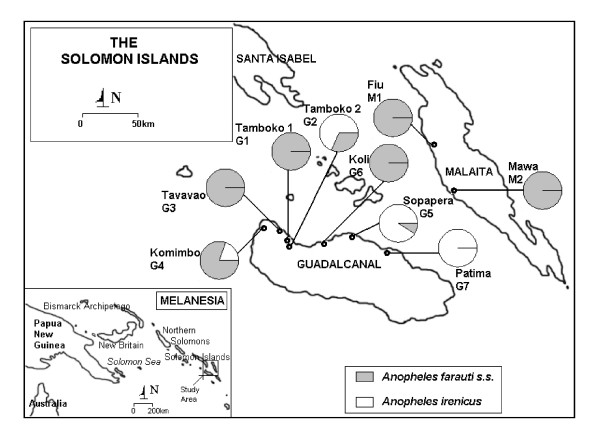
Collection sites and frequencies of Anopheles farauti s.s. and Anopheles irenicus mosquitoes used in this study. Dots indicate several nearer sampling sites. Pie charts represent the proportion of species collected from each site. Inset: The study area within Melanesia is shown.